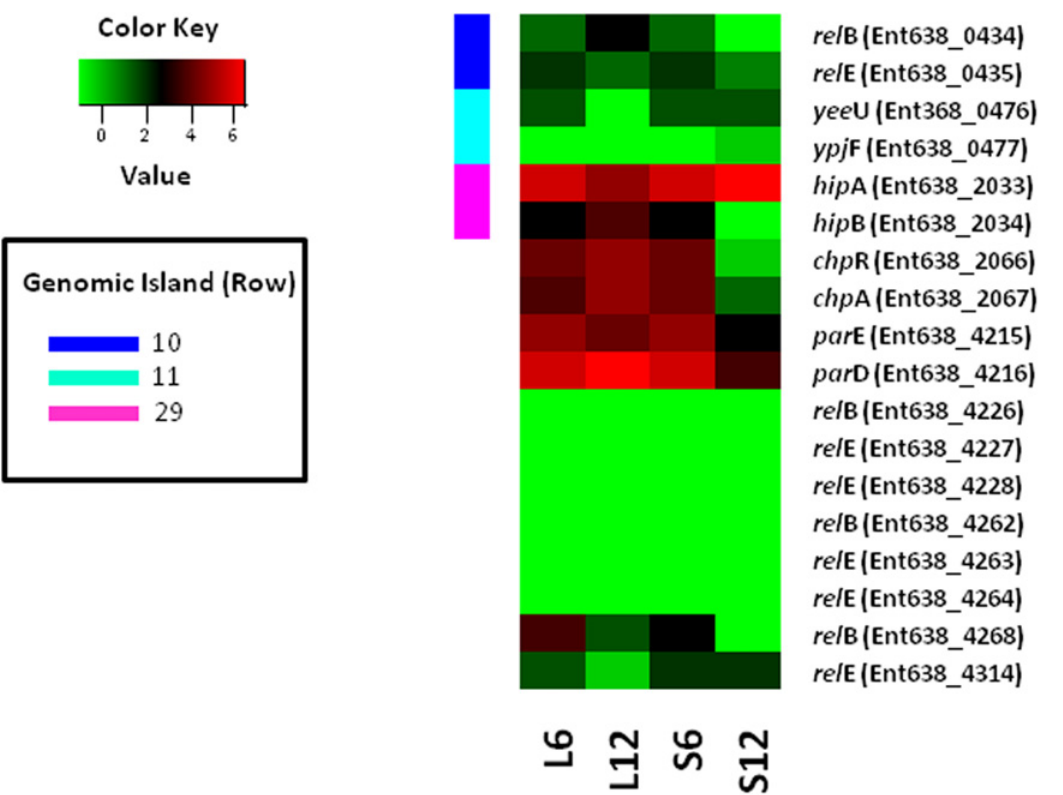
Figure 3. Expression levels of various toxin/anti-toxin systems found in Enterobacter sp. 638 in function of carbon source. Log 2 of normalized gene expression values (RPKM) are plotted for each condition. L6, L12, S6 and S12 represent the condition lactate and sucrose after 6 and 12 hours growth,